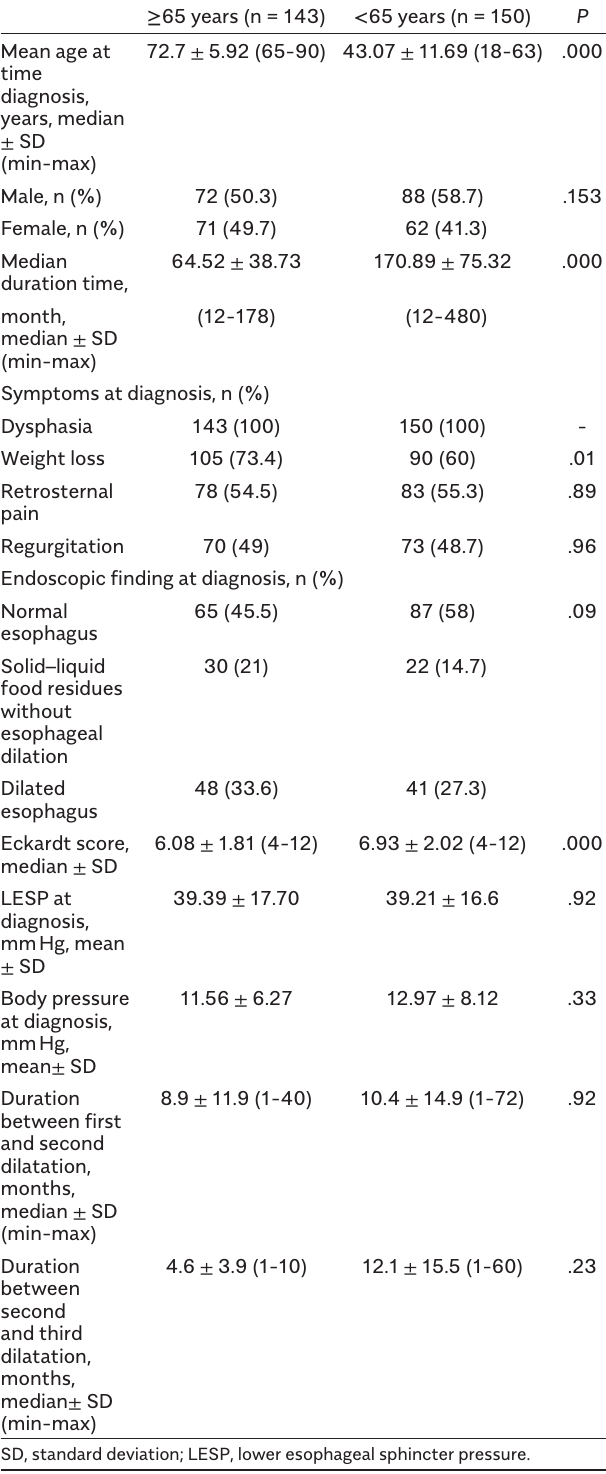
Table 1. Characteristic and Demographic Features of